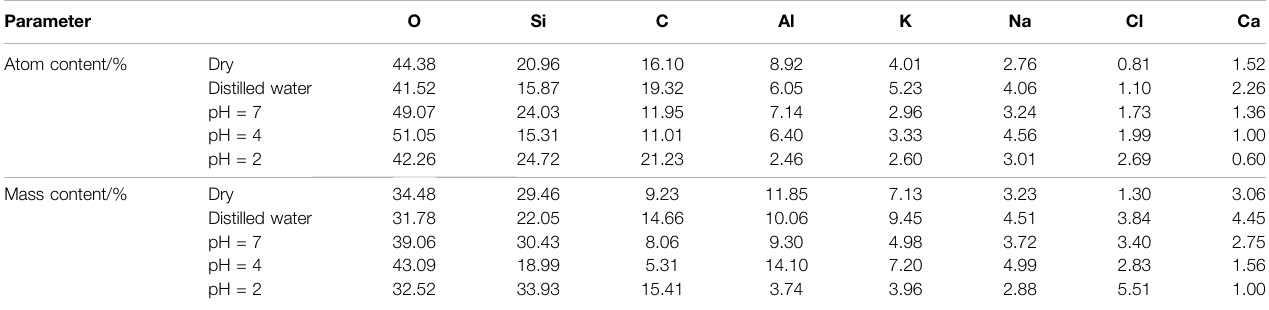
TABLE 1 | Comparison of the atomic number and mass content of the main components of granite under the fl ow rate of v = 150 mm · s − 1 with different aqueous chemical solutions for 49 days. Parameter O Si C Al K Na Cl Ca Atom content/% Dry